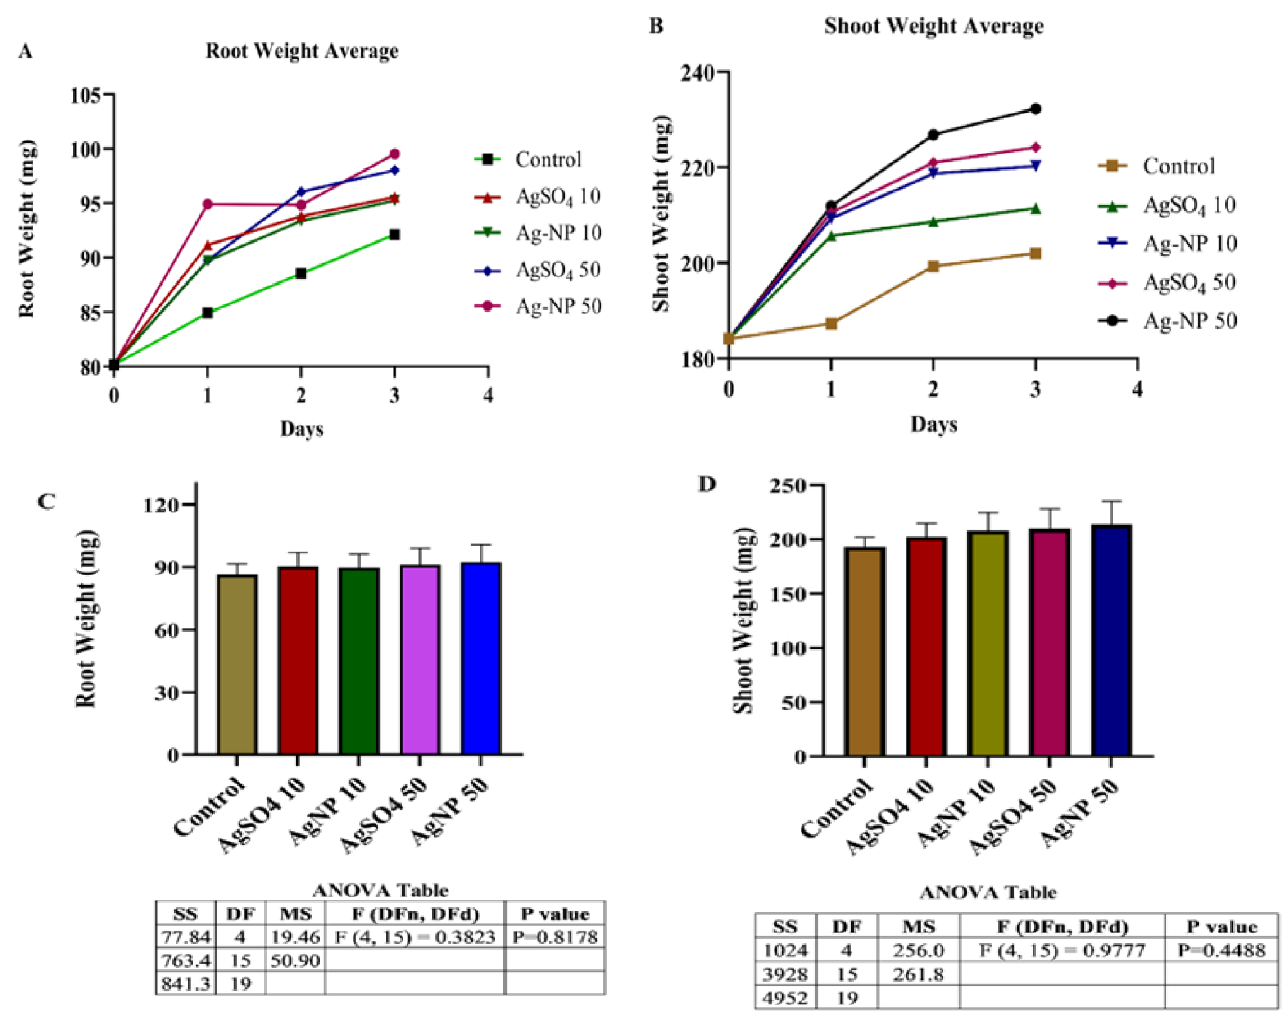
Figure 8. ( A ) Effects of Ag-NPs on root weight, ( B ) effects of Ag-NPs on shoot weight, ( C ) root length average error bar, and ( D ) shoot length average error bar.